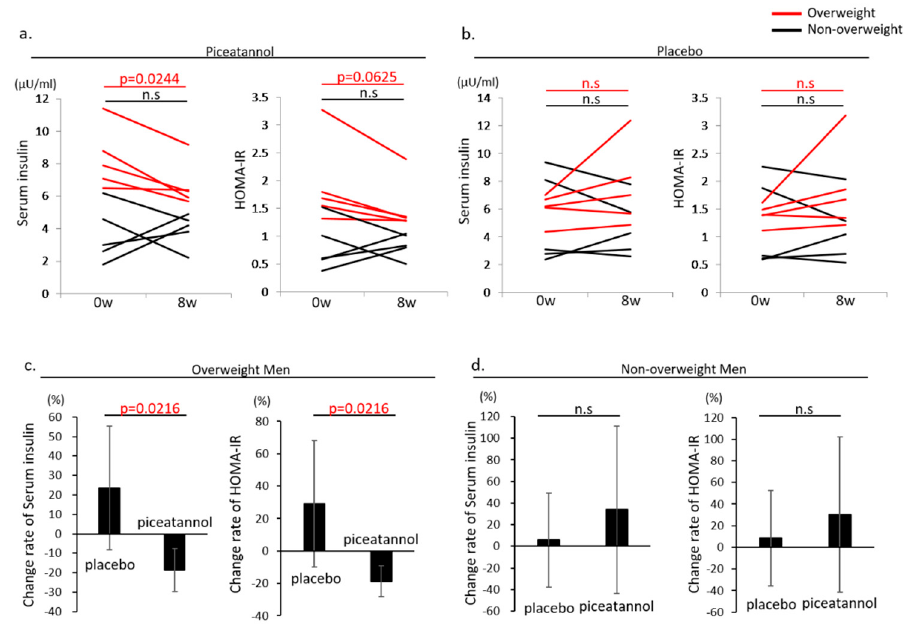
Figure 2. Serum insulin levels and HOMA-IR in overweight (shown as a red line) or non-overweight (shown as a black line) men at baseline and 8 weeks after piceatannol supplementation ( a ) or placebo ( b ). p values between two groups are shown, and n.s. denotes no significance. Change rate of serum insulin levels and HOMA-IR in overweight ( c ) or non- overweight ( d ) men at baseline and after 8 weeks of piceatannol supplementation or placebo. p values between two groups are shown, and n.s. denotes no significance.